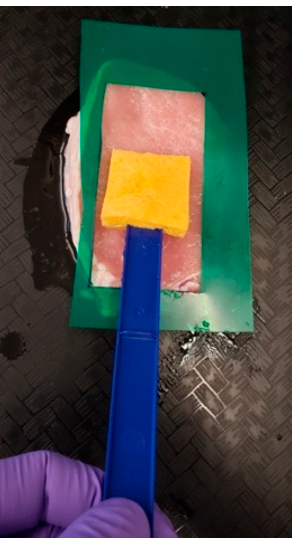
Figure 1. Meat surface swabbing using a sponge moistened in BPW (buffered peptone water).